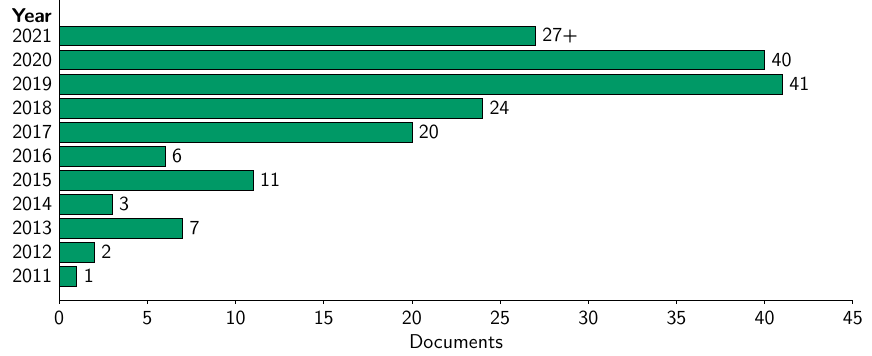
Figure 15. Year-wise published documents worldwide on adopting UAVs for PV (until 15 November 2021).